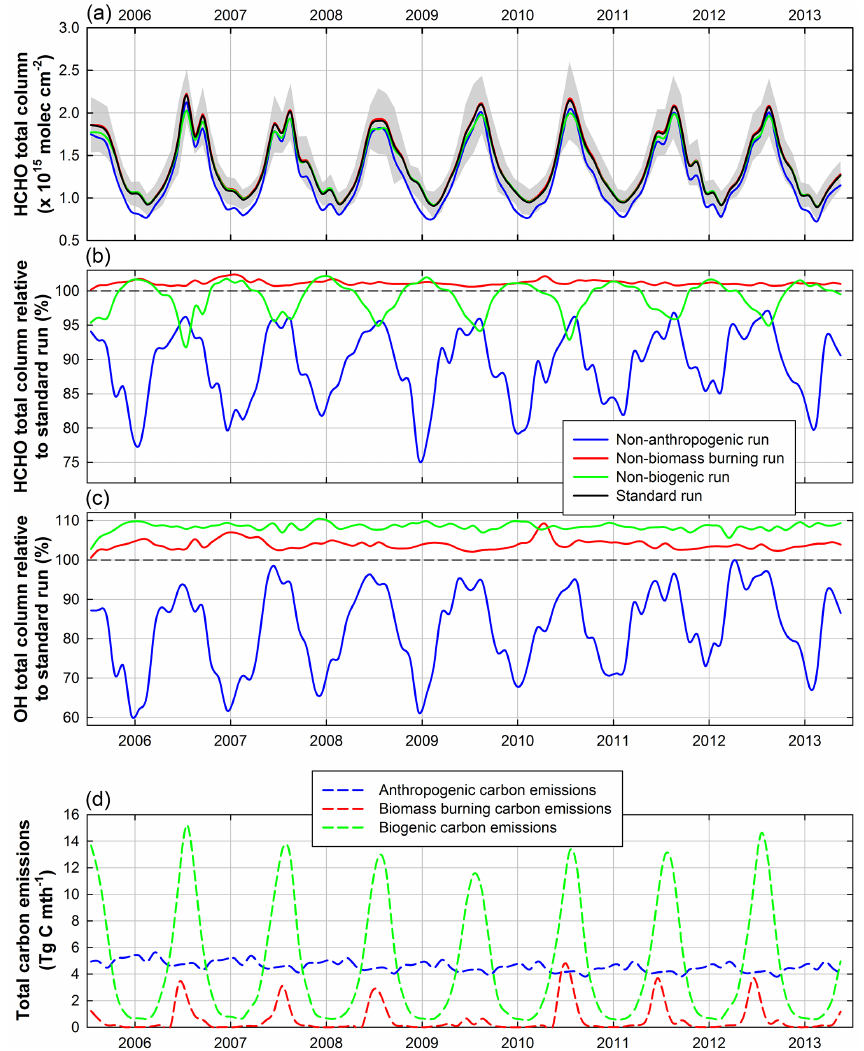
Figure 5. (a) Monthly mean of the daily averaged HCHO total column (in moleccm − 2 ) above Jungfraujoch simulated by GEOS-Chem v9-02 over the July 2005–May 2013 time period, according to the standard and sensitivity (i.e., non-anthropogenic, non-biomass burning and non-biogenic) runs. In the sensitivity simulations, the anthropogenic, biomass burning and biogenic emissions of NMVOCs and NO have been shut off, while the CH 4 concentrations are still derived from NOAA measurements, as for the standard simulation. The grey shaded area corresponds to the 1 σ standard deviation associated with the standard run. (b) HCHO total column from the sensitivity runs, as relative to the HCHO amount simulated by the standard run (in % of the latter). (c) The same as (b) but for OH. (d) Monthly total carbon emissions (in TgCmonth − 1 ) by category, integrated over 30–60 ◦ N and − 130–35 ◦